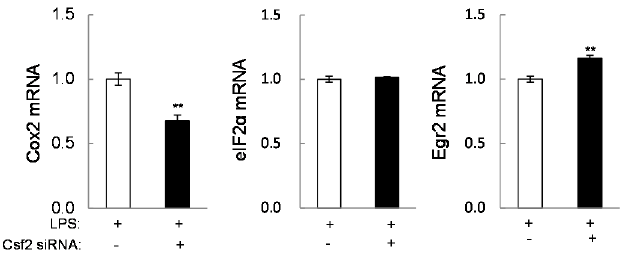
Figure 6. Effects of a partial silencing of Csf2 on the mRNA levels of the selected genes in LPS-stimulated RAW264.7 cells. The single and double asterisk indicates p < 0.05 and p < 0.01, respectively. ( A , B ) Reduction of Csf2 by treatment with Csf2 siRNA; ( C ) levels of IL1 β , IL6, TNF α , Cox2, eIF2 α , and Egr2 mRNAs in response to Csf2 siRNA treatment in LPS-stimulated RAW264.7 cells. 2.5. Direct Linkage of eif2 α Signaling to IL6, Cox2, and Csf2